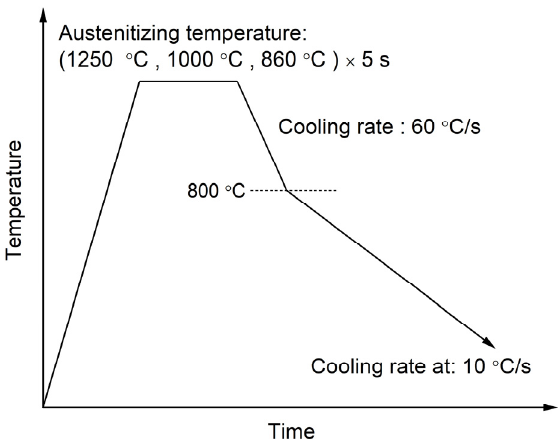
Figure 1. Schematic of the simulated heat treating process with different austenitization tempera-